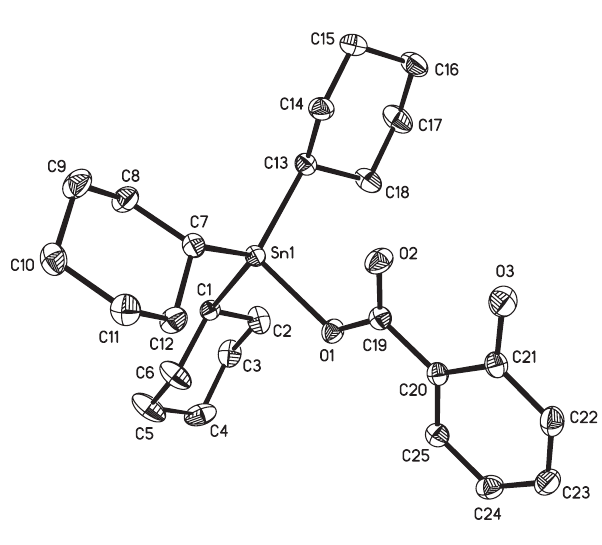
Figure 1: The molecular structure of 1 . Hydrogen atoms are omitted for